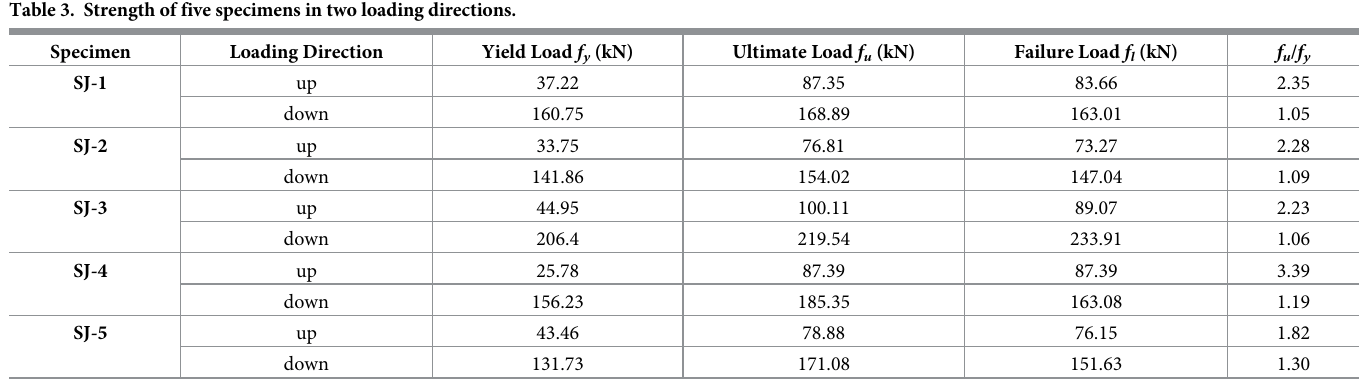
Table 3. Strength of five specimens in two loading